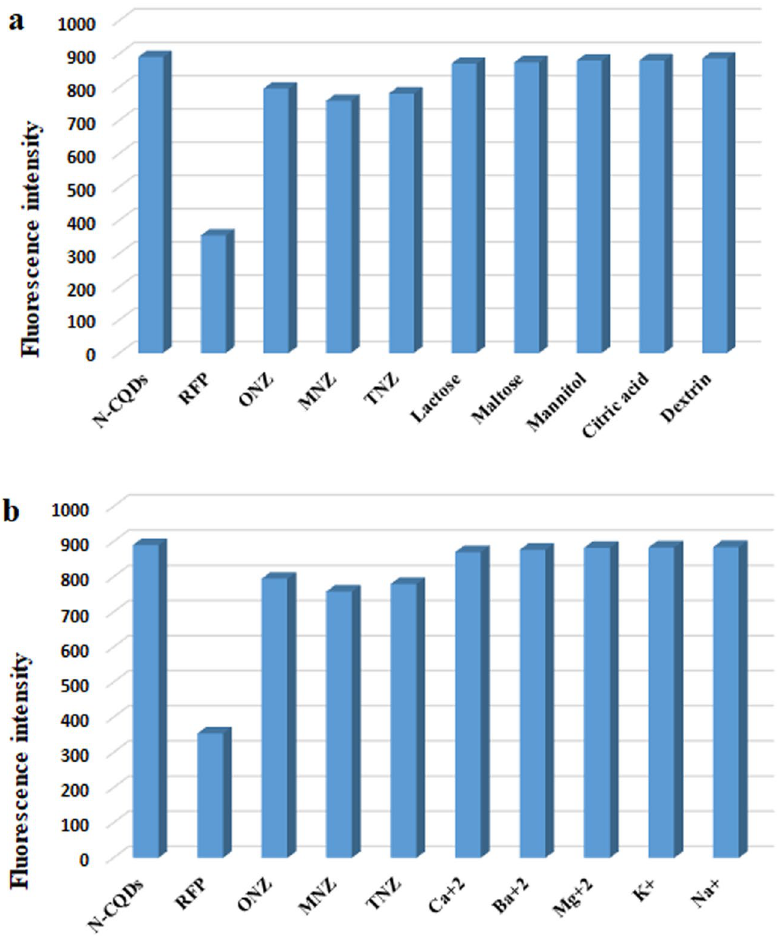
Figure 11. (a) The response of possible interfering excipients, (b) The selectivity of SN-CQDs towards ONZ, RFP, TNZ, and MNZ in presence of different metal